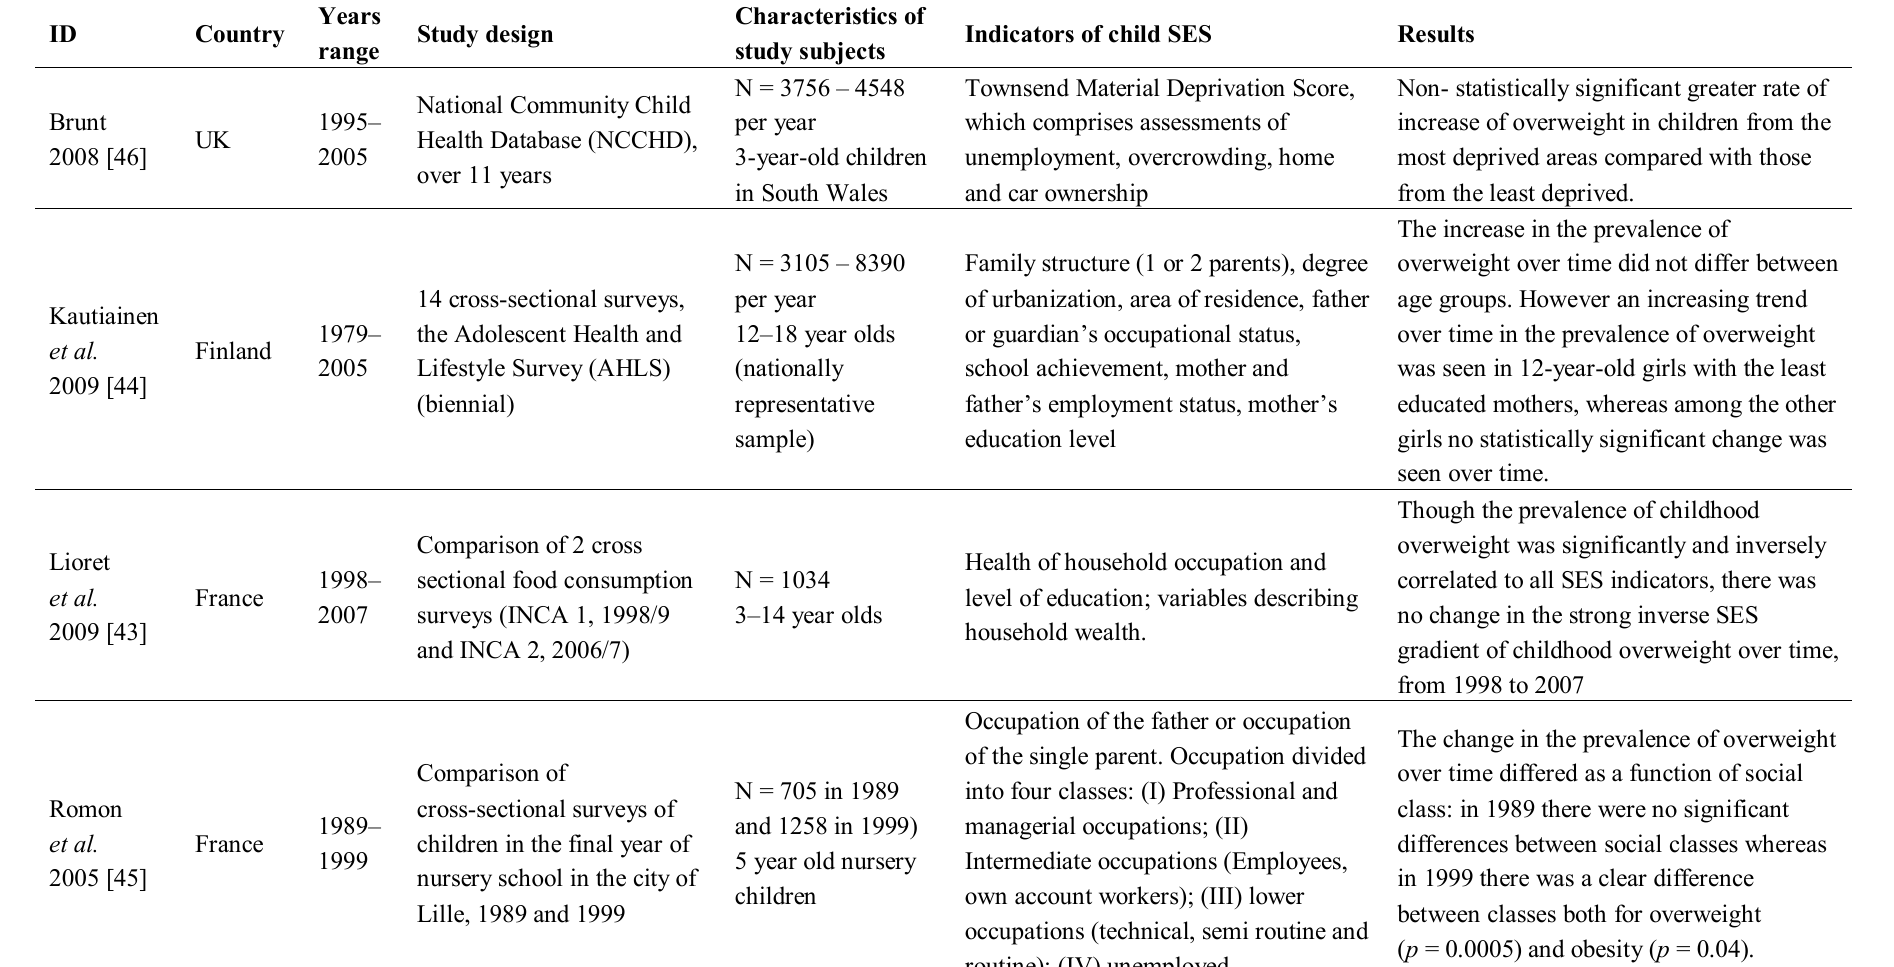
Table 2. Characteristics of seven included